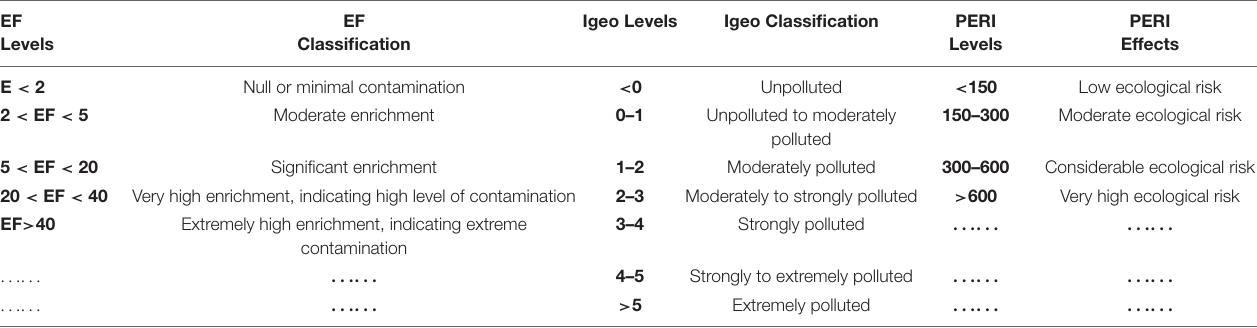
TABLE 2 | Reference for the classification of enrichment factor (EF; Sutherland, 2000), geoaccumulation index (Igeo; Müller, 1986), ecological risk index (RI; Protano et al., 2014), individual by sample, and potential ecological risk index (PERI) as a whole per sample (Håkanson, 1980; Swarnalatha et al.,